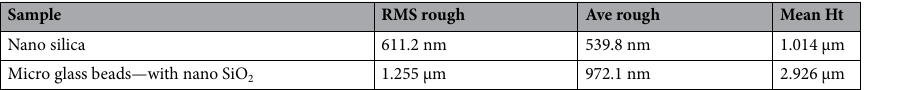
Table 2. Calculated AFM parameters for nanosilica and PTFE coating with glass beads microparticles in the primer layer and with SiO 2 nanoparticles in the overcoat layer.